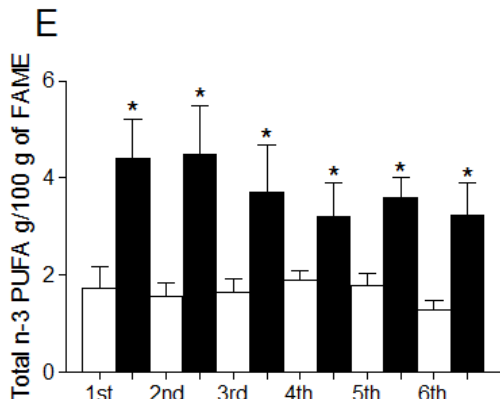
Figure 1. Total fatty acid composition of breast milk from mothers during nursing. Saturated fatty acids (SFA) ( A ); Monounsaturated fatty acids (MUFA) ( B ); Polyunsaturated fatty acids (PUFA) ( C ); Total n-6 PUFA ( D ); Total n-3 PUFA (E). Data are expressed as g fatty acid per 100 g FAME and represent the mean ± SD for n = 21 women (control group) and n = 19 (chia group). Statistical significance ( p < 0.05); * : indicates significantly different when comparing the chia group with the control group for each month of nursing ( t -test) and for all months of nursing (One-way ANOVA and Newman-Keuls test). SFA correspond to 6:0, 8:0, 10:0, 12:0, 14:0, 16:0, 18:0, 20:0 and 22:0, 24:0. MUFA correspond to 14:1 n-5, 16:1 n-7 and 18:1, n-9. PUFA correspond to 18:2 n-6, 18:3 n-3, 20:4 n-6, 20:5 n-3, 22:5 n-3 and 22:6 n-3.